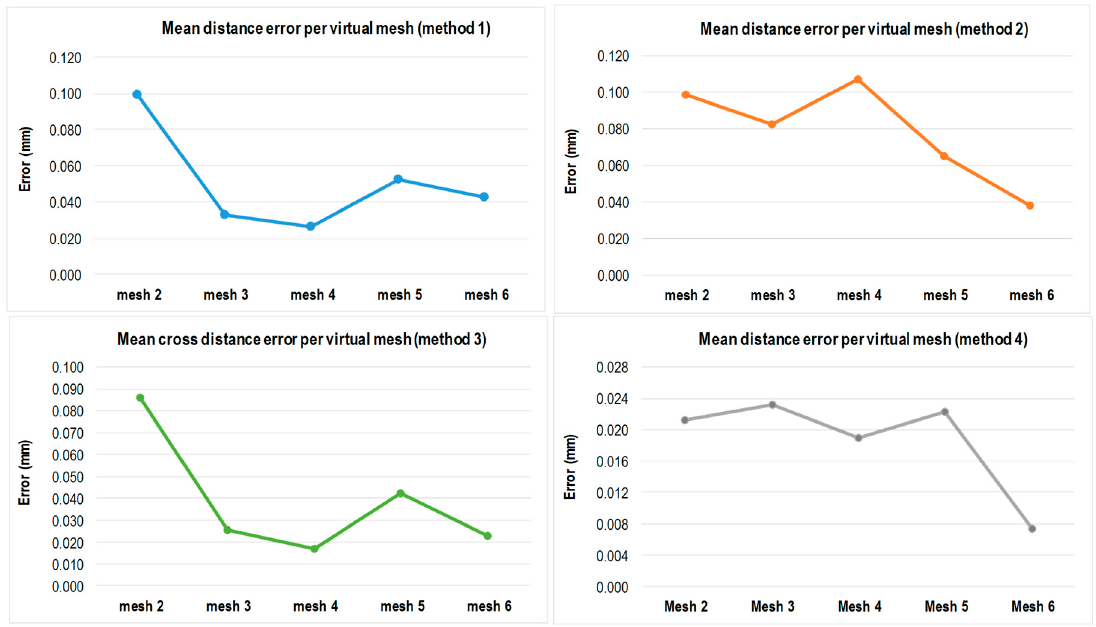
Figure 11. Mean distance error per virtual mesh.